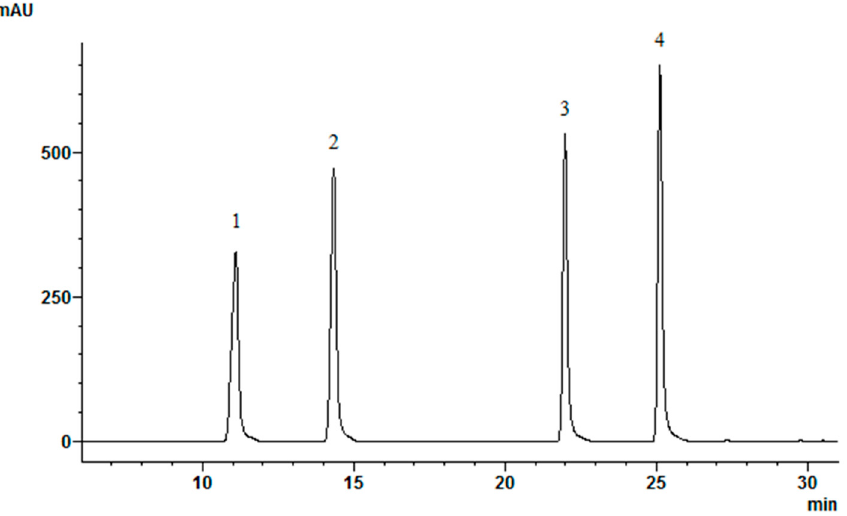
Figure 3. Isoflavone separation HPLC-DAD chromatogram: 1-daidzin; 2-genistin; 3-daidzein; 4-genistein.